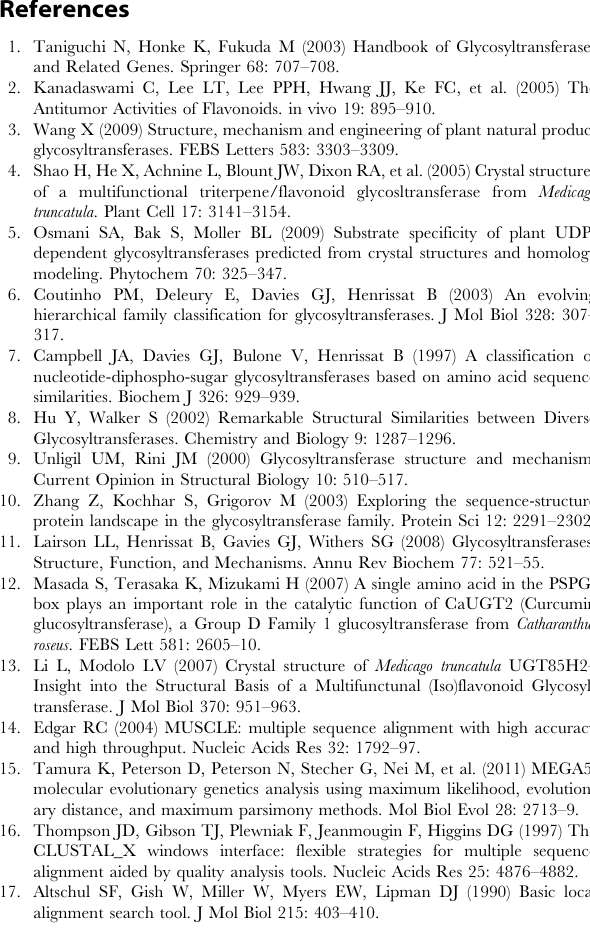
Figure S6 Image showing docked complexes of three positive control ligands in the acceptor binding pocket of Scutellaria baicalensis . (TIF) Table S1 Details of box size and number of water molecules added during simulation process. Table S2 Percent identity matrix of 30 F3GT protein sequences. Table S3 Dataset of 101 GT protein sequences taken for the phylogenetic study. Table S4 Statistics of Blast